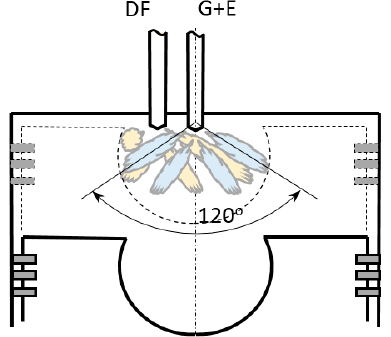
Figure 5. Location of 2 common rail injectors for glycerol-ethanol ( 𝐺 + 𝐸 ) and diesel fuel ( 𝐷𝐹 ).